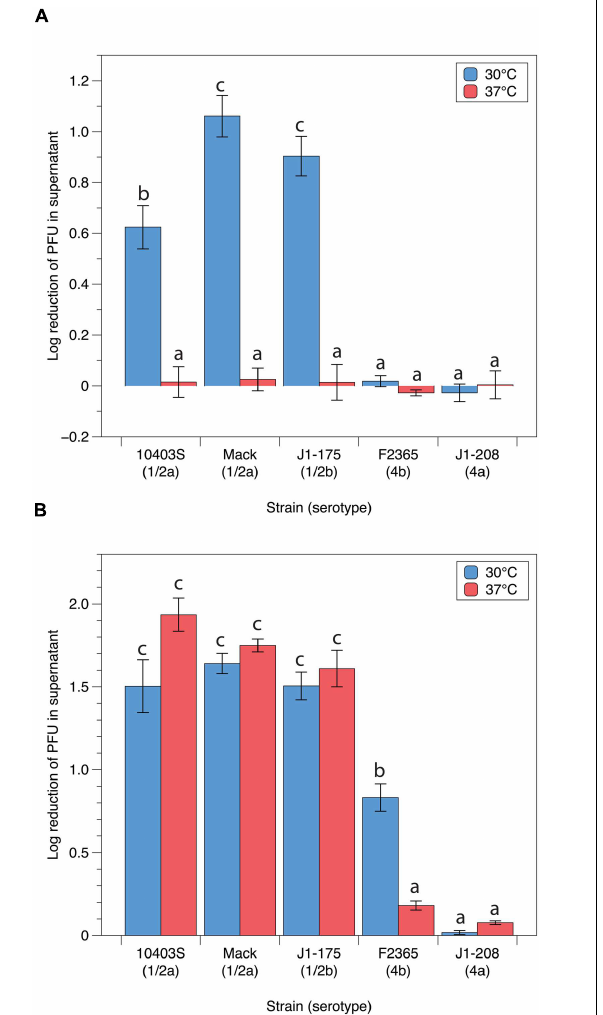
FIGURE 4 | Adsorption efficiencies of P100-like phages (A) LP-048 and (B) LP-125 at 30 ◦ C and 37 ◦ C. Values shown are the log 10 reduction of free phage in the supernatant of each co-incubation between phage and host. The log 10 reduction is calculated by subtracting the log-transformed number of phage left in in the supernatant from the log-transformed number of phage in the negative control (BHI). Lower values represent less efficient adsorption. Bars that do not share any letters represent values that are significantly different; for example, a bar marked with b is significantly different from a bar marked with c. Three biological replicates were conducted. Error bars represent the standard